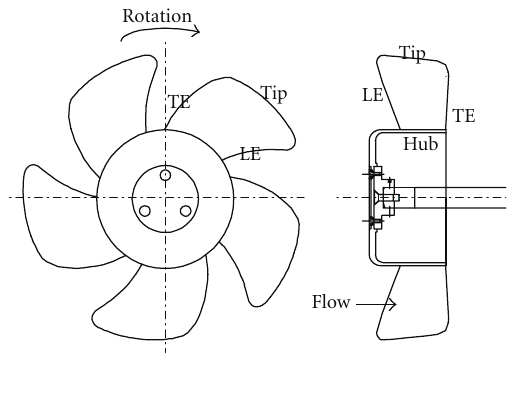
Figure 3: Outlines of test